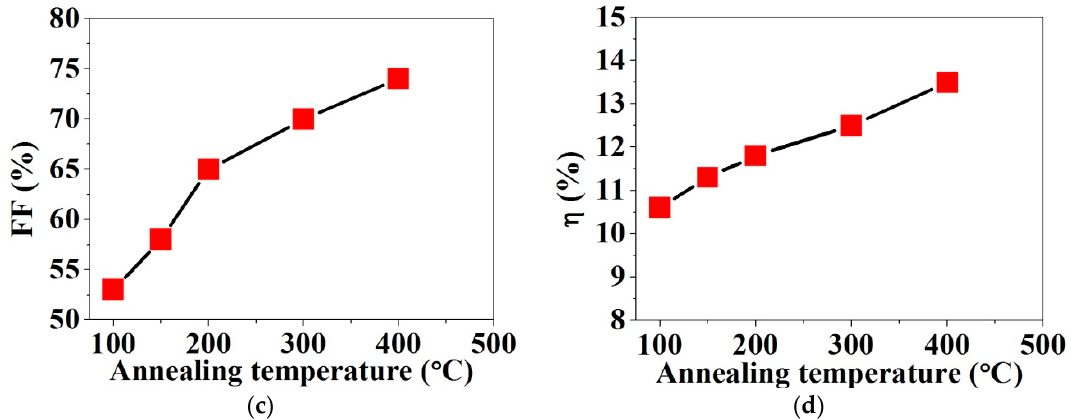
Figure 6. I–V parameters of copper indium gallium selenium (CIGS) solar cells as a function of annealing temperature of Mo electrodes: ( a ) change of the open circuit voltage (Voc) with different annealing temperature; ( b ) change of the short circuit current density (Jsc) with different annealing temperature; ( c ) change of the fill factor (FF) with different annealing temperature; and ( d ) change of the photo-conversion efficiency( η ) with different annealing